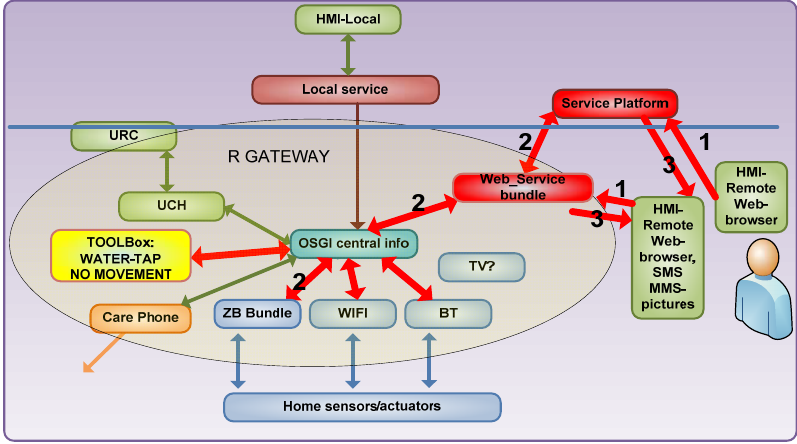
Figure 4. Service communications mapped on technology blocks allowed for inter-team understanding and Quality of Service and responsibility of faults assessment. Information on demand from a relative to monitor a dependant person and check an alert received.